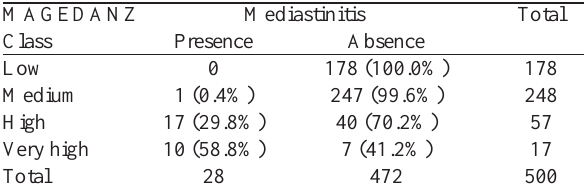
Table 4. Relationship between Magedanz SCORE